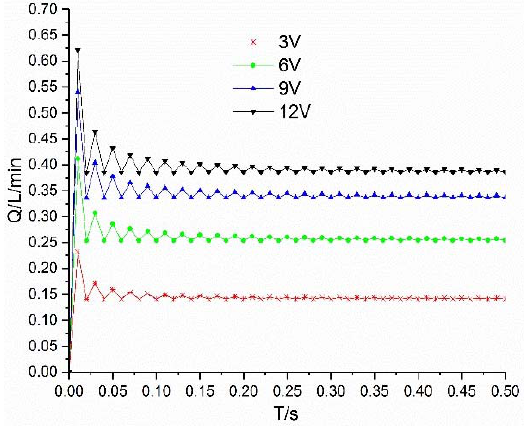
Figure 10. Flow curves under different voltages.